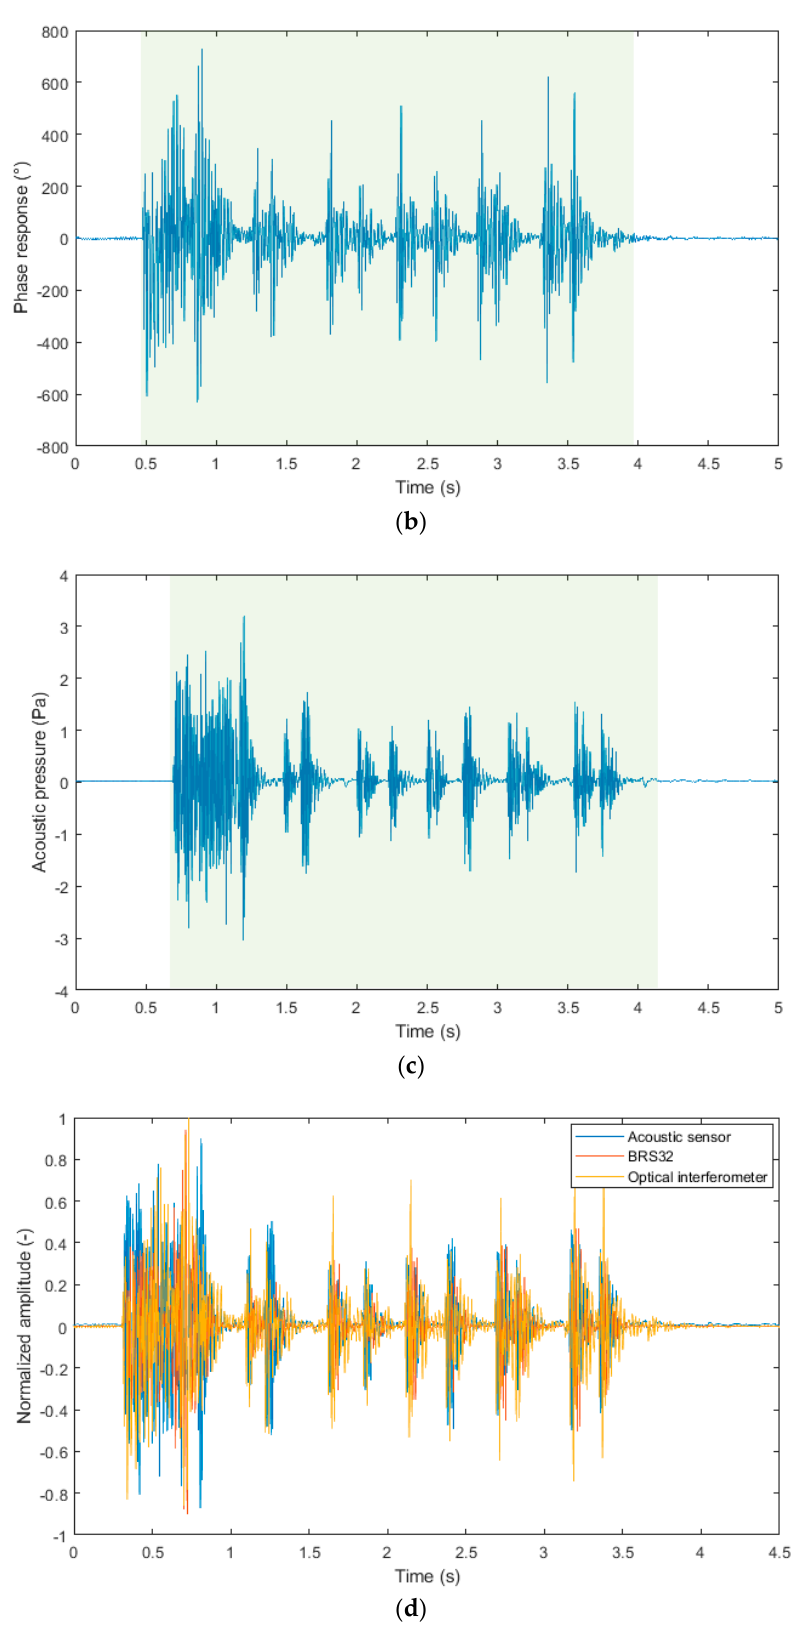
Figure 14. The waveform images from the blasting operation recording of 26 April 2019: ( a ) Seismic apparatus BRS32; ( b ) interferometric sensor; ( c ) acoustic sensor; ( d ) graphical comparison of the three records described above in one